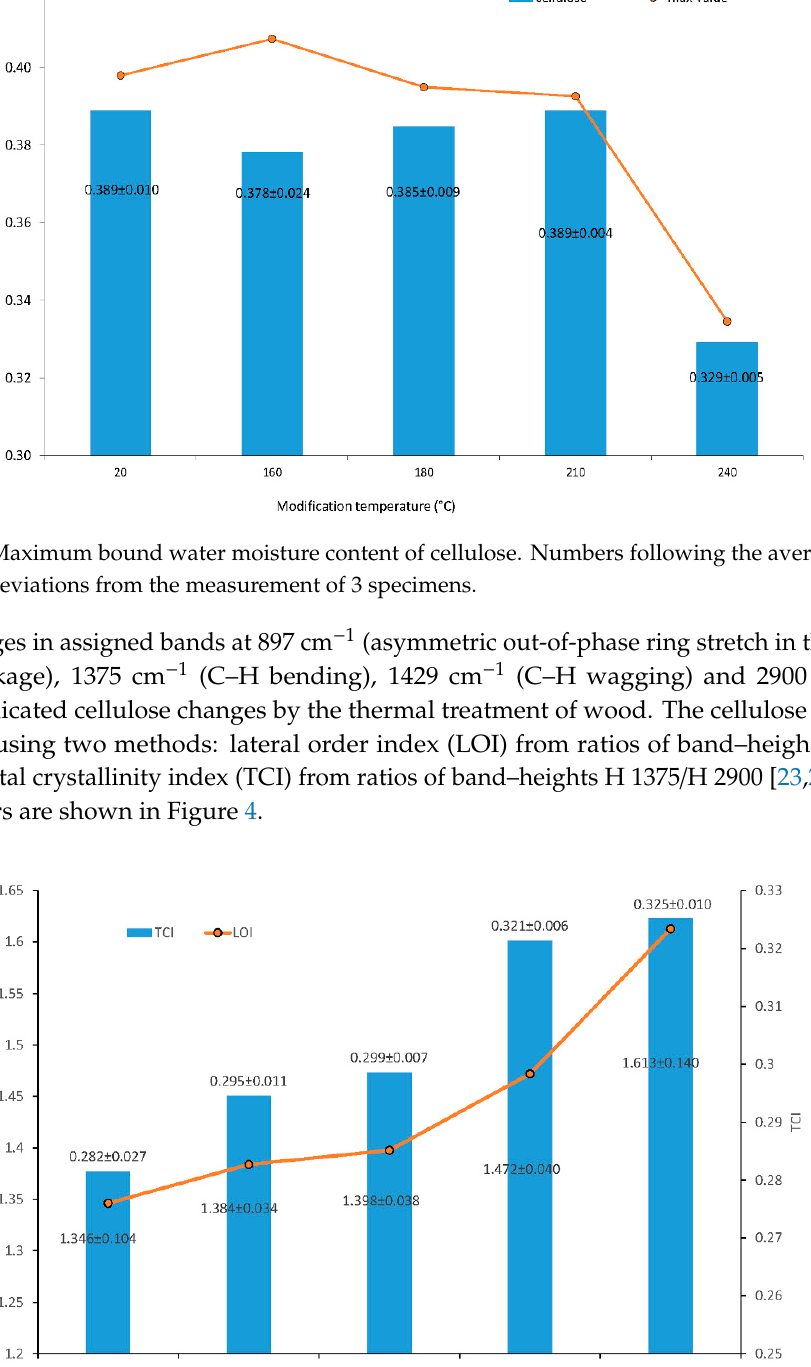
Figure 3. Maximum bound water moisture content of cellulose. Numbers following the averages are standard deviations from the measurement of 3 specimens.